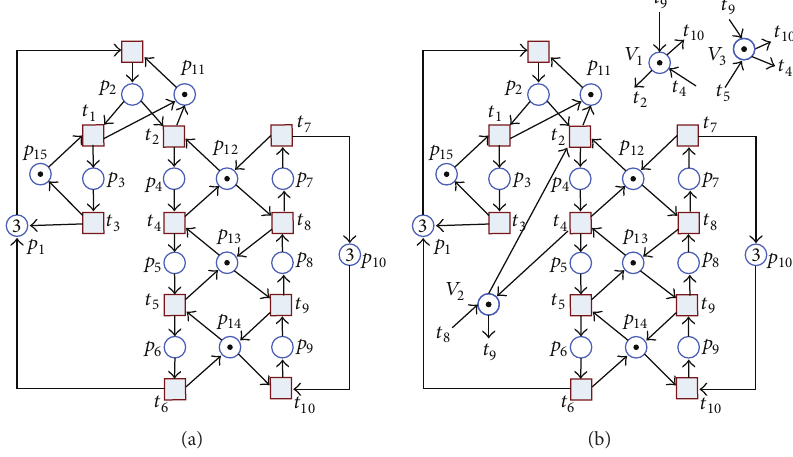
Figure 4: (a) An ordinary M-net (𝑁,𝑀 0 ) and (b) controlled system (𝑁 1𝑐 , 𝑀 1𝑐 ) .